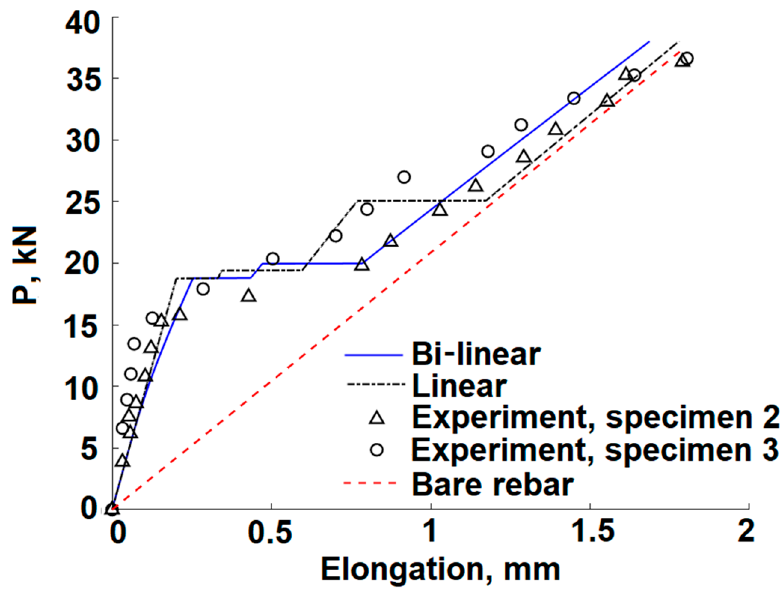
Figure 8. Comparison of bar elongation [10] .